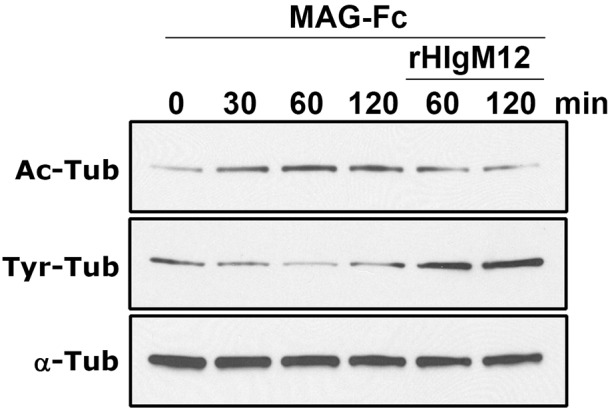
Soluble MAG-Fc-driven reduction of tyrosinated tubulin is reversed by the addition of rHIgM12. MAG-Fc binds to GD1a and GT1b on neurons in culture and promotes microtubule stability, including increasing the level of acetylated α-tubulin (Ac-Tub), while decreasing levels of tyrosinated α-tubulin (Tyr-Tub) (Nguyen et al., 2009; Xu et al., 2011b). To test whether rHIgM12 could antagonize the effects of MAG-Fc, cortical neurons in culture were treated with 10 µg/ml of MAG-Fc alone for 2 h. Neuronal lysates probed with antibodies specific for Ac-Tub and Tyr-Tub show that, whereas the total level of α-tubulin remained constant, Ac-Tub increased and Tyr-Tub fell. In comparison, when 10 µg/ml of rHIgM12 was added to the culture media along with MAG-Fc, the levels of Tyr-Tub were dramatically higher 1 and 2 h later and Ac-Tub decreased to baseline 0 time-point levels, indicating active microtubule assembly. The panel shows one of three iterations.